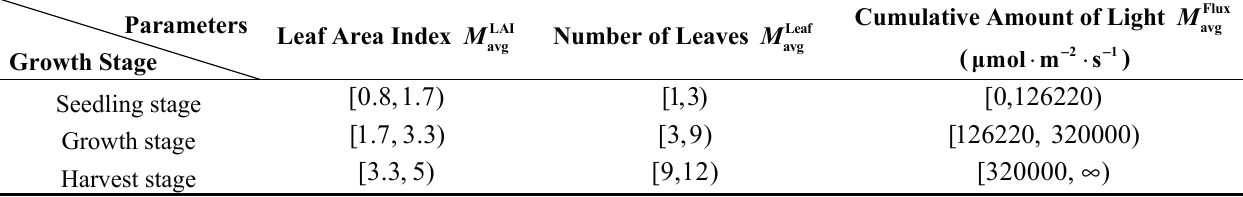
Table 3. Plant growth stages corresponding to plant growth response intervals.